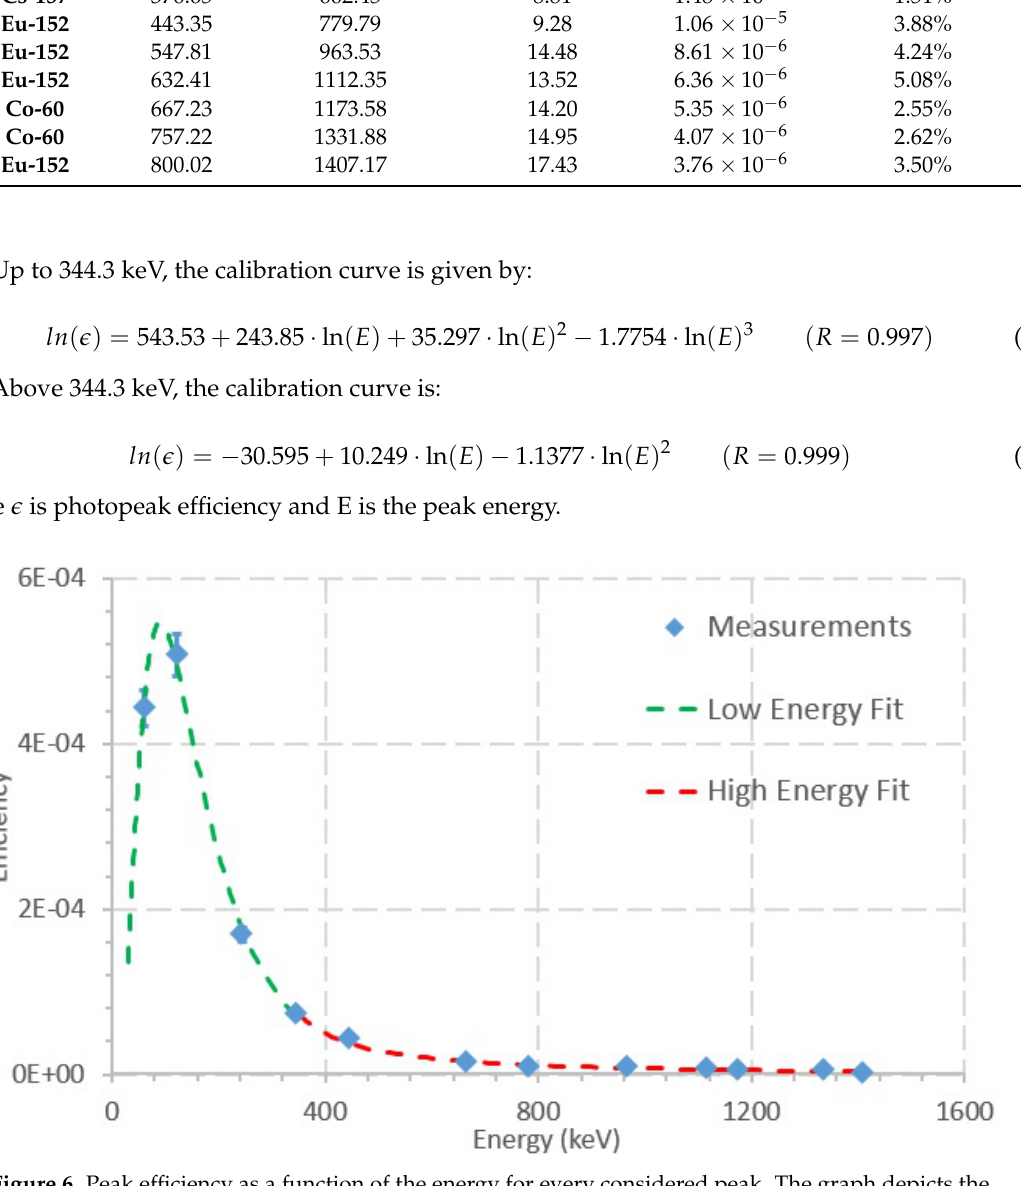
Figure 6. Peak efficiency as a function of the energy for every considered peak. The graph depicts the measurements for each peak in blue and the Low Energy Fit (second-degree polynomial fit, up to 344.3 keV, green) and the High Energy Fit (third-degree polynomial fit, above 344.3 keV,